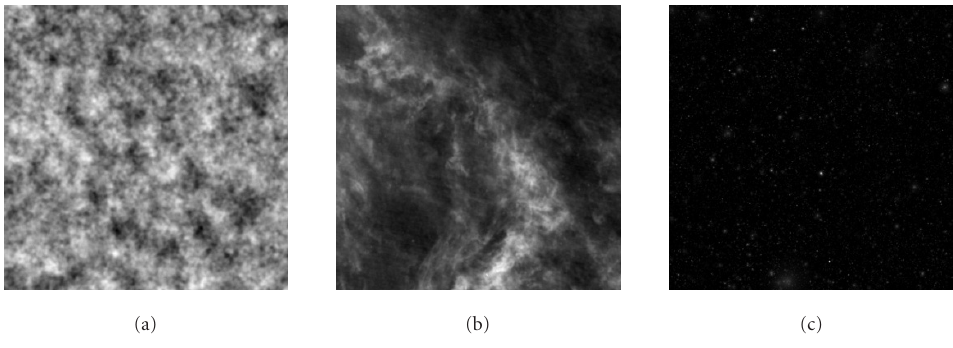
Figure 2: Samples of simulated component maps of CMB, dust, and